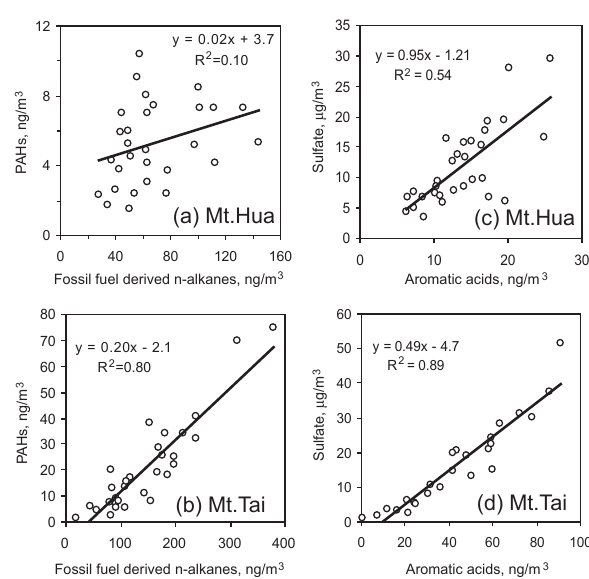
Fig. 5. Linear fit regression for fossil fuel-derived n -alkanes with PAHs and aromatic acids with sulfate in the PM 10 samples at Figure 5. Linear regression fit for fossil fuel derived n-alkanes, PAHs, sulfate and aromatic acids Mt. Hua and Mt. Tai during the non-dust storm period (samples in the PM10 samples collected at Mt. Hua and Mt. Tai during the non-dust storm period collected in rainy days were (samples collected in rainy days were excluded)